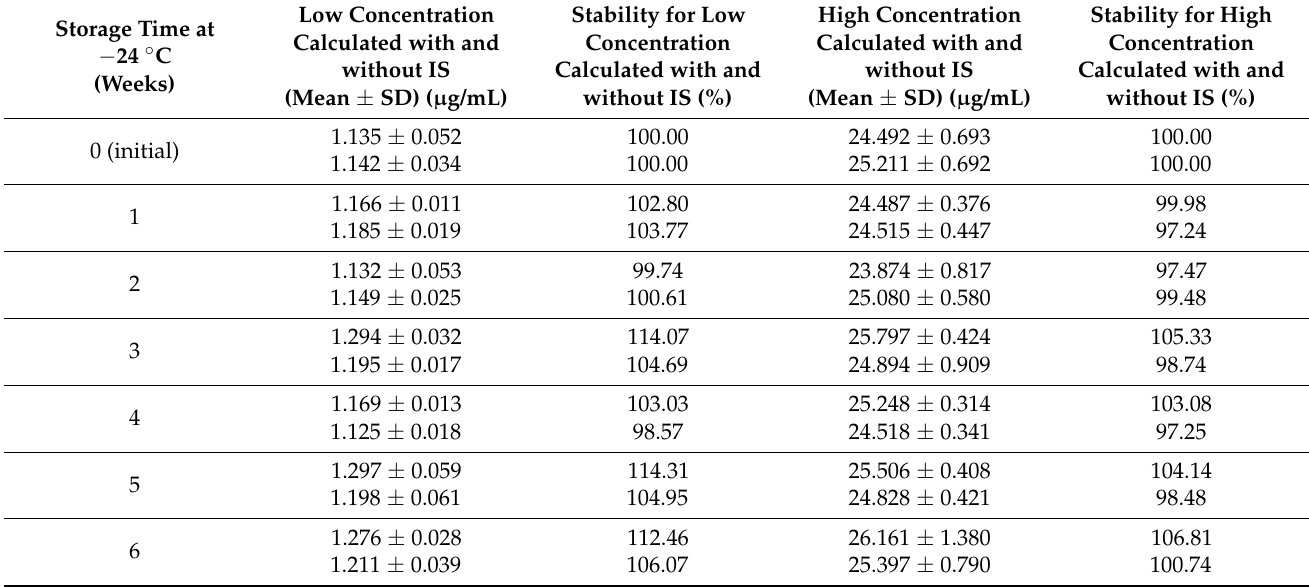
Table 2. Long-term stability ( n = 3).